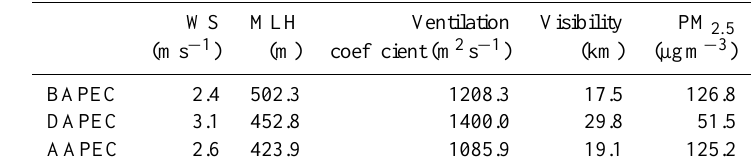
Figure 5. AOD values and 0–4500m column attenuated backscattering coefficient vs. time (a) and their correlations (b) . Table 1. Meteorological conditions and atmospheric particle concentrations during BAPEC, DAPEC and AAPEC.